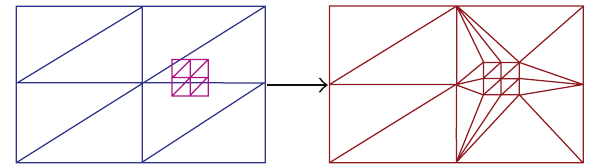
Figure 4: Stenciling a plane over a bigger